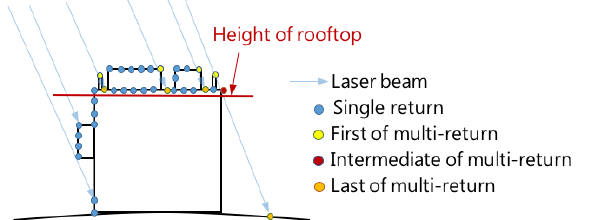
Figure 6. The concept of selecting laser points above the height of rooftop.